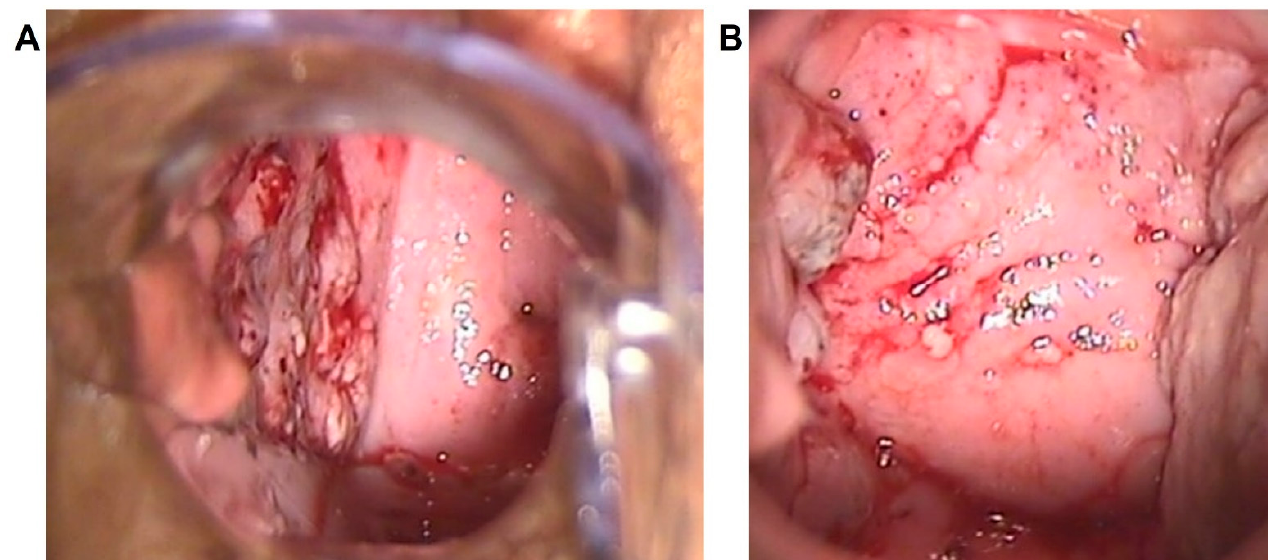
Figure 1. Colposcopic grade according to the 2011 IFCPC Colposcopic Terminology. ( A ): Grade 1 or minor, as shown by the colposcopic pattern (thin acetowhite epithelium) of a patient diagnosed with VAIN1, located at the upper third of the right vaginal wall. ( B ): Grade 2 or major, as shown by the colposcopic pattern (coarse mosaic) of a patient diagnosed with VAIN3, located at the vaginal vault, after previous hysterectomy for CIN3.